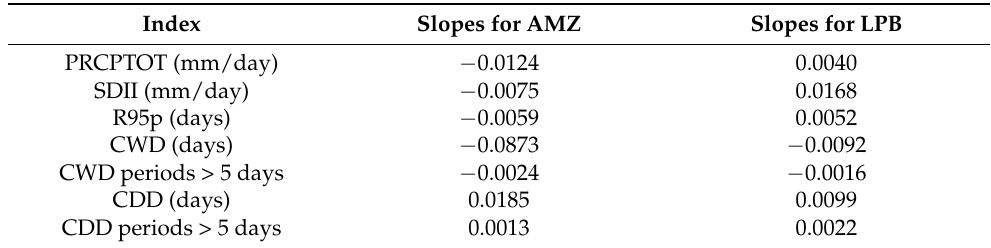
Table 3. Trend slopes (per year) obtained for the AMZ and LPB time series. All values presented Figure 9. Changes projected to CDD (days) during austral summer computed from each RCM en ‐ semble (Eta, RegCM, and REMO) and 3RCMs ensemble (right column) and considering four statistically significant trends ( α = 0.05), except PRCPTOT for LPB.